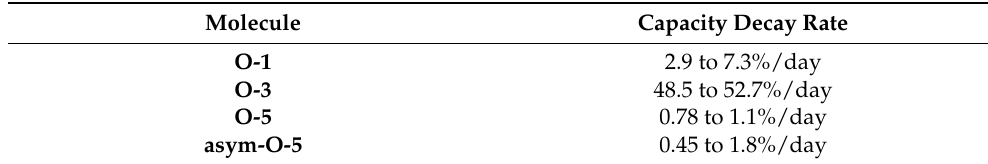
Table 3. Summary of the stability of studied